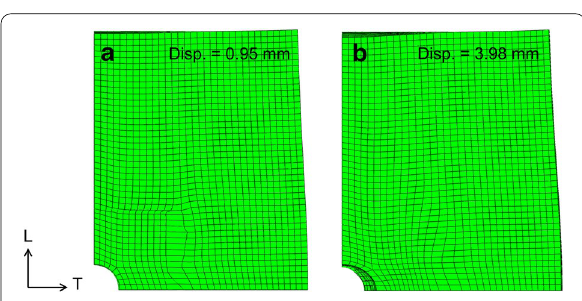
Fig. 6 Deformation of wood at final step in ( a ) S40T6 and ( b ) S80T2.3, whose scale is magnified 10 and 5 times, respectively (L: longitudinal, T: